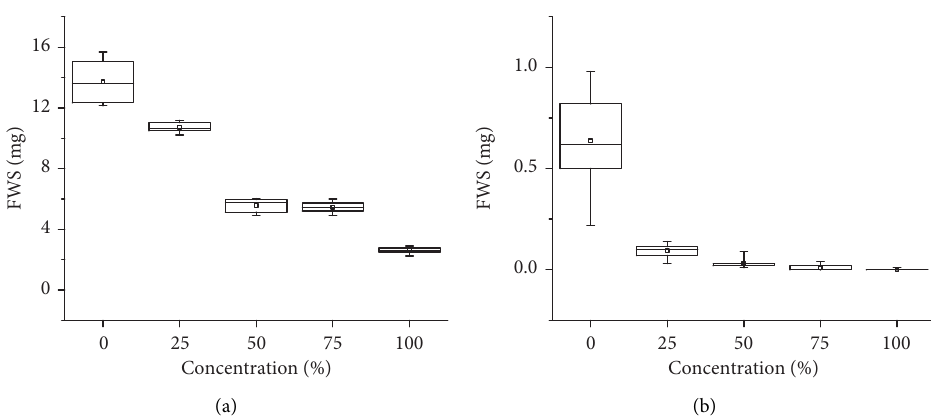
Figure 6: Fresh weight of shoot (FWS) of germinated P. vulgaris (a) and O. sativa (b) seedlings in laboratory experiment after 7 and 14 days of treatment with S. suaveolens extracts, respectively.